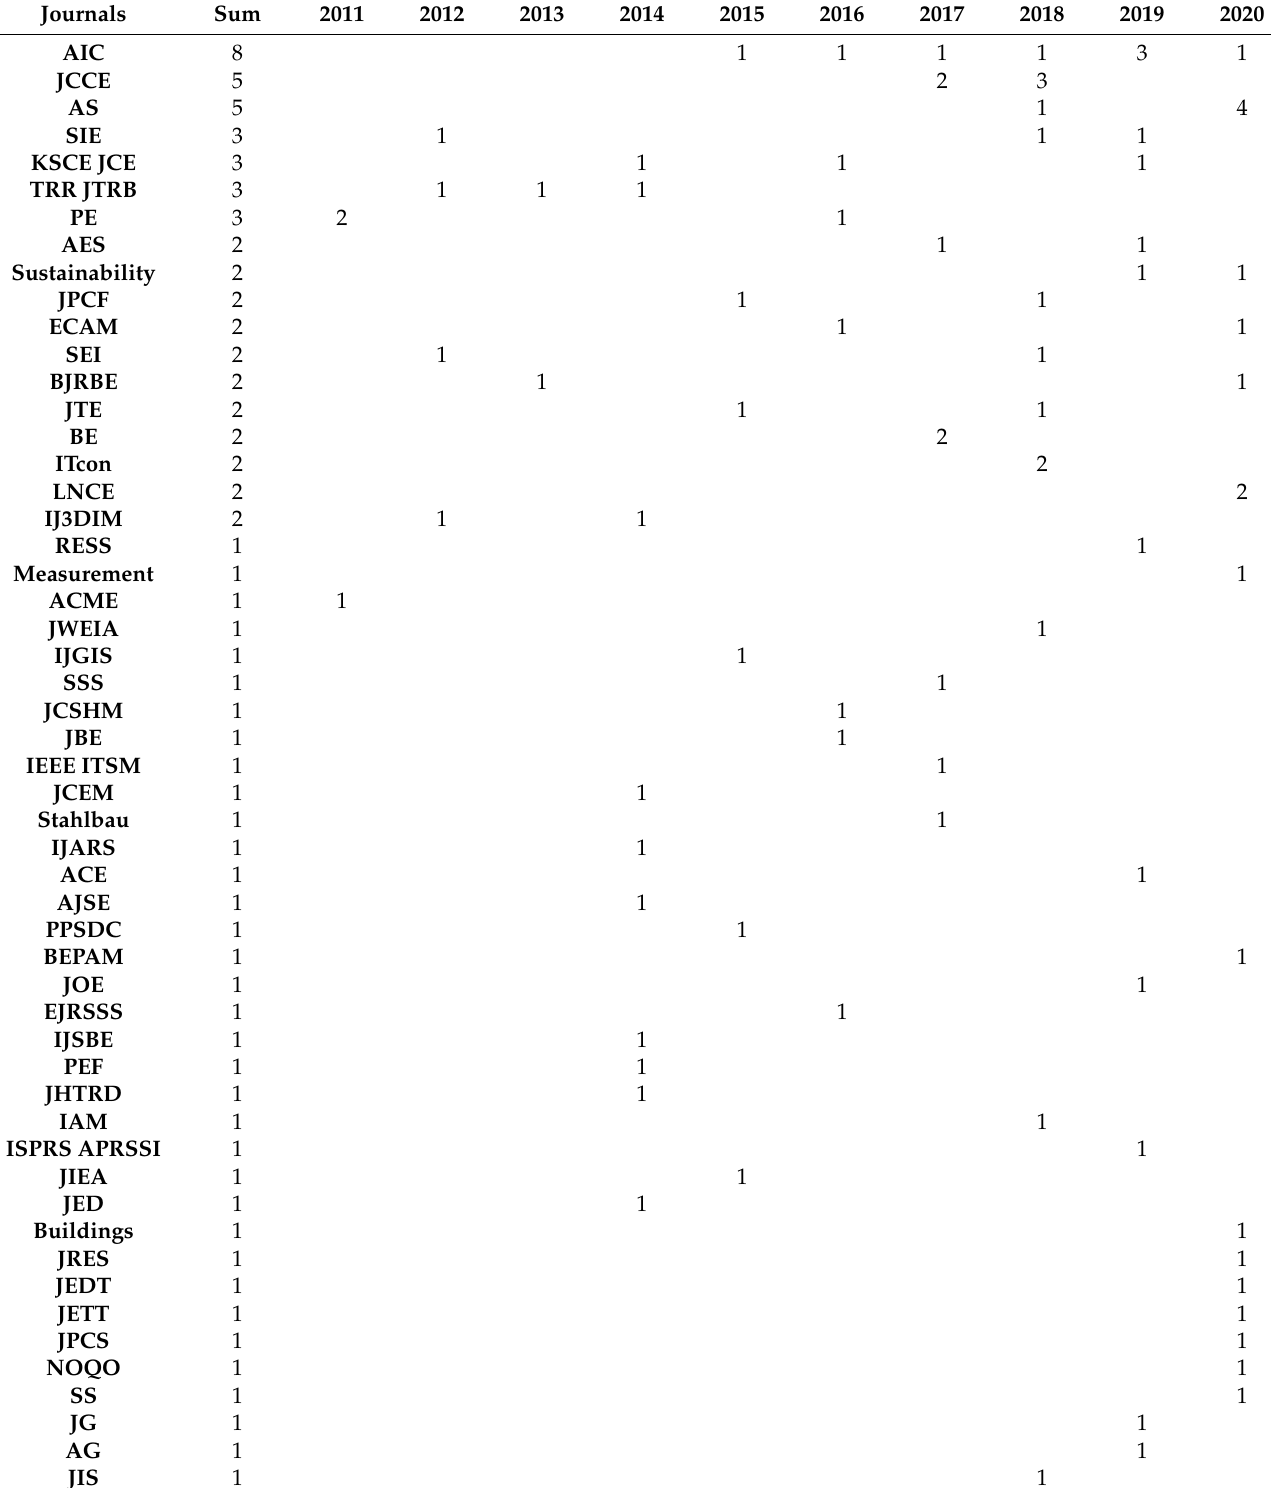
Table 1. The table shows a growing trend of research from 2011 to 2020. Table 1 also shows that the research on BIM technology (i.e., 58) is twice as much as GIS technology (i.e., 30). Only two studies investigated the combination of BIM and GIS for bridges. Table 1. Paper distribution in terms of journal and year of publication and